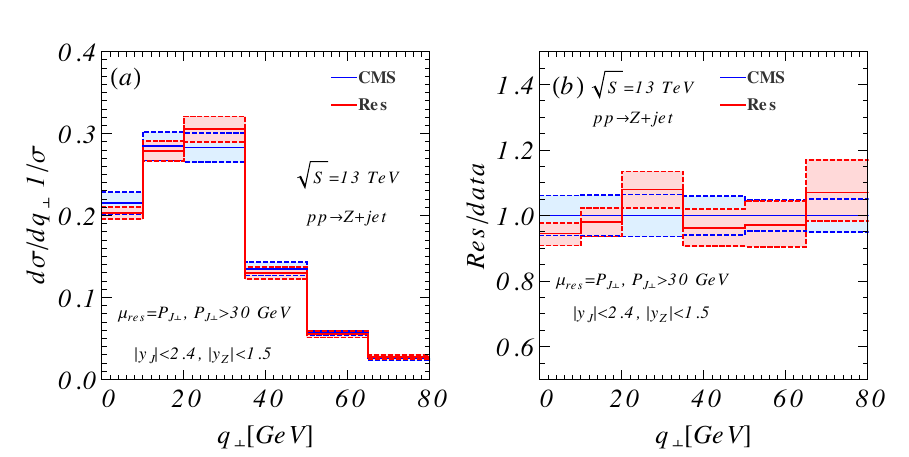
distribution of the Z boson plus one jet system, produced at the √ S = 13 TeV Figure 1. (a) The normalized q ⊥ y < 2 . 4 and P > 30 GeV. The blue and red bands represent the CMS experimental uncertainty [9] LHC with J | J | ⊥ and the resummation calculation (Res) scale uncertainty, respectively. (b) The ratio of resummation prediction to CMS data as a function of q . ⊥